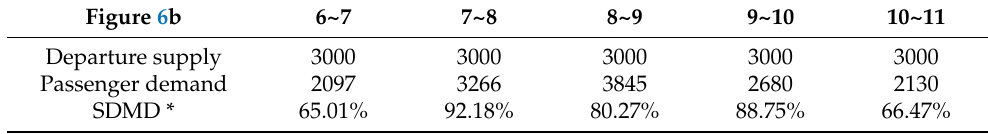
Table 9. Details of supply and demand matching degree of single-cycle timetable in scenario 2. Figure 6b Table 8. Details of supply and demand matching degree of multi-cycle timetable in scenario 2.